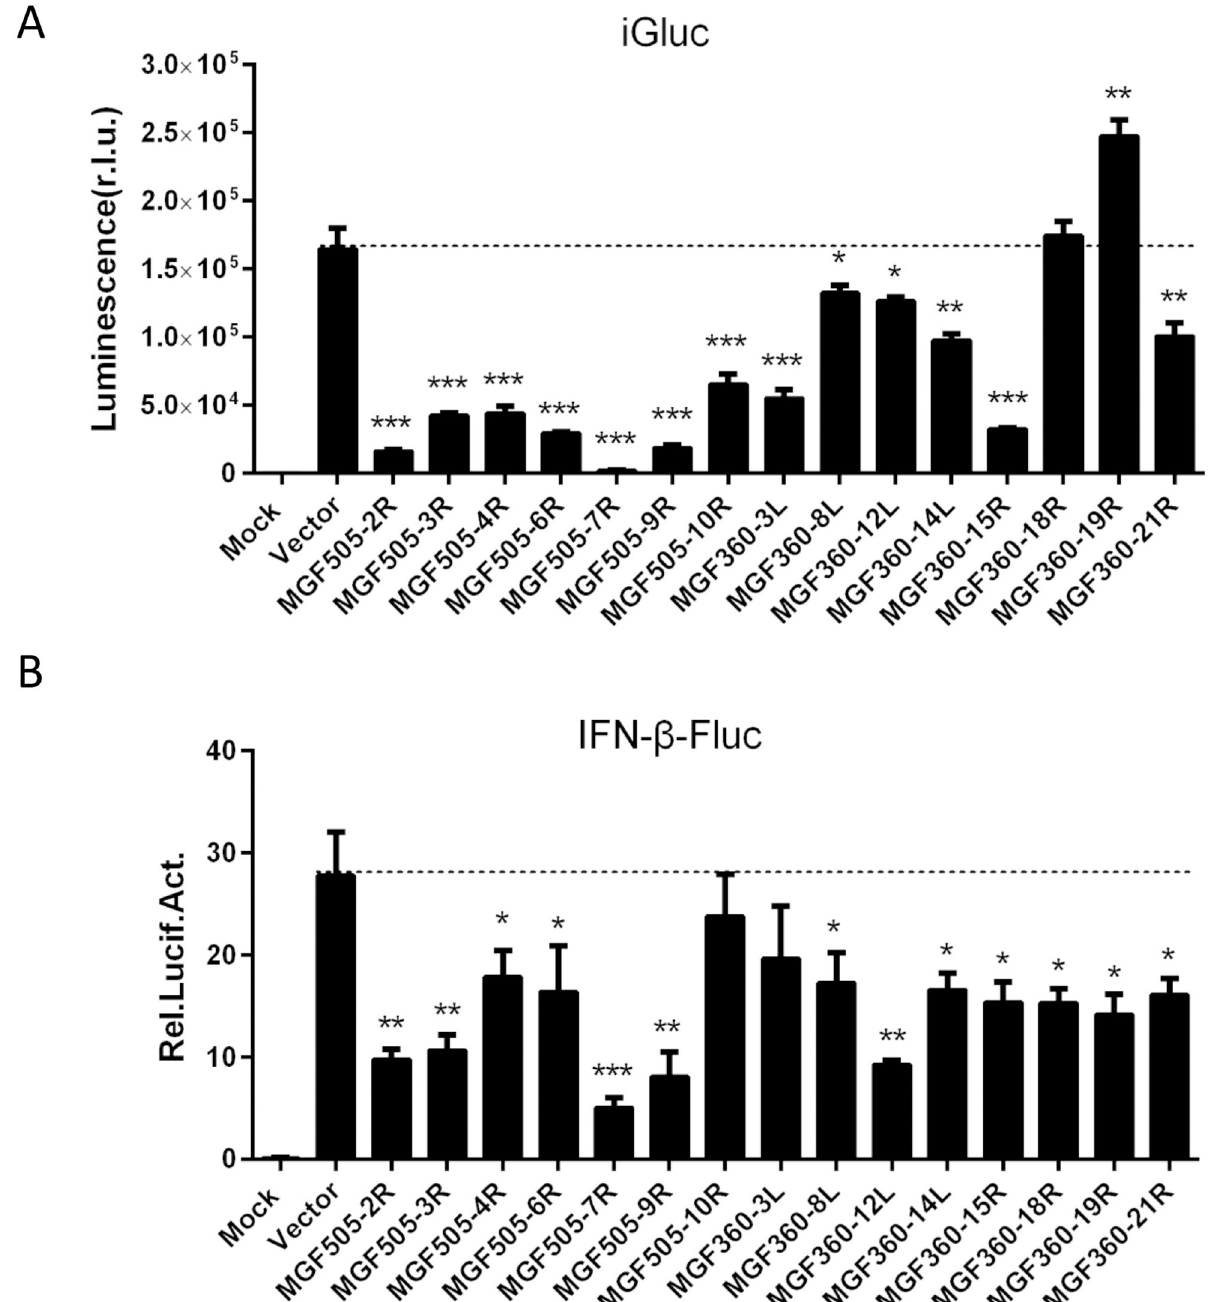
Fig 3. Screening for ASFV-encoded MGFs that inhibit IL-1 β and IFN- β production. (A) HEK293T cells were transfected with a plasmid expressing one of the ASFV-encoded pMGFs in the presence of the iGLuc-based NLRP3 inflammasome system (100 ng iGLuc, 10 ng pCAGGS-caspase-1, 10 ng pCAGGS-ASC, and 12.5 ng pCAGGS-NLRP3), and the supernatants were assessed for luciferase activity at 24 hpt. (B) HEK293T cells were transfected with a plasmid expressing one of the ASFV-encoded pMGFs alone with 100 ng of a reporter plasmid and 5 ng of the pRL-TK plasmid for 24 h and then the cells were stimulated with poly(I:C) (1 μ g). At 12 hpt, the cells were collected and the luciferase activities were measured. A p value of less than 0.05 was considered statistically significant. � p < 0.05, �� p < 0.01, ��� p < 0.001.